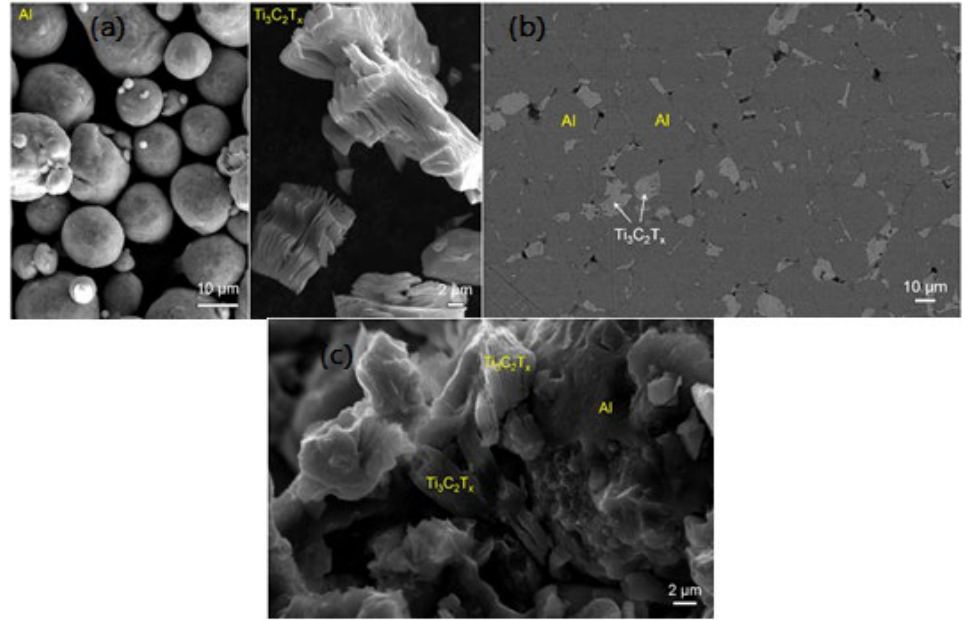
Figure 18. SEM micrographs of the initial powders ( a ), and polished surface ( b ) and fracture surface ( c ) of the samples sintered at 650 °C in Ar for 1 h. The left- and right-hand-side micrographs in ( a ) show the morphologies of Al and Ti 3 C 2 T x powders, respectively. Reprinted with permission from [71]. Copyright 2018 materials MDPI.